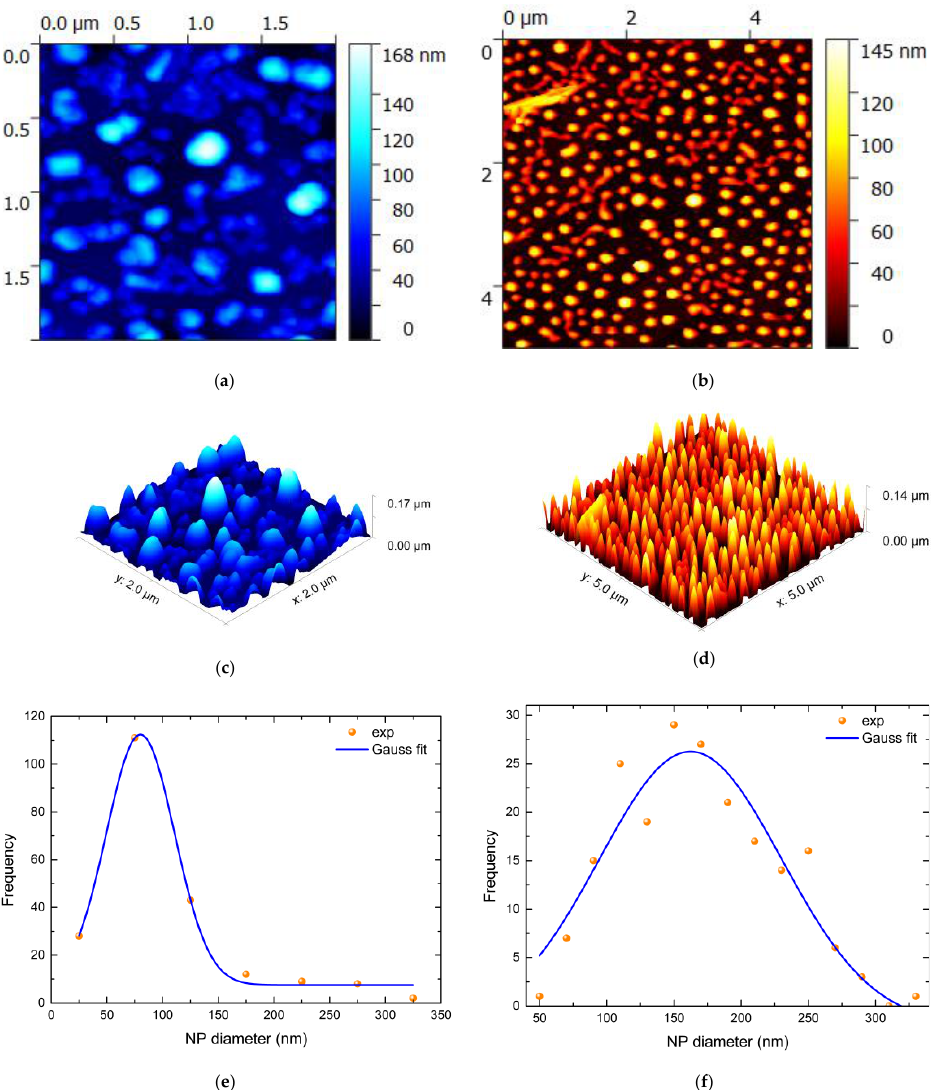
Figure 14. Two- and three-dimensional AFM images and nanoparticle size distribution diagrams ( a , c , e ) for the area of the AgPd #2 (12.3 nm) multilayer that was thermally annealed at 460 °C for 20 min, and ( b , d , f ) for the area of the same multilayer that was laser-annealed with 20 passes. The multilayer was cut into two pieces so that both annealing methods could be carried out.